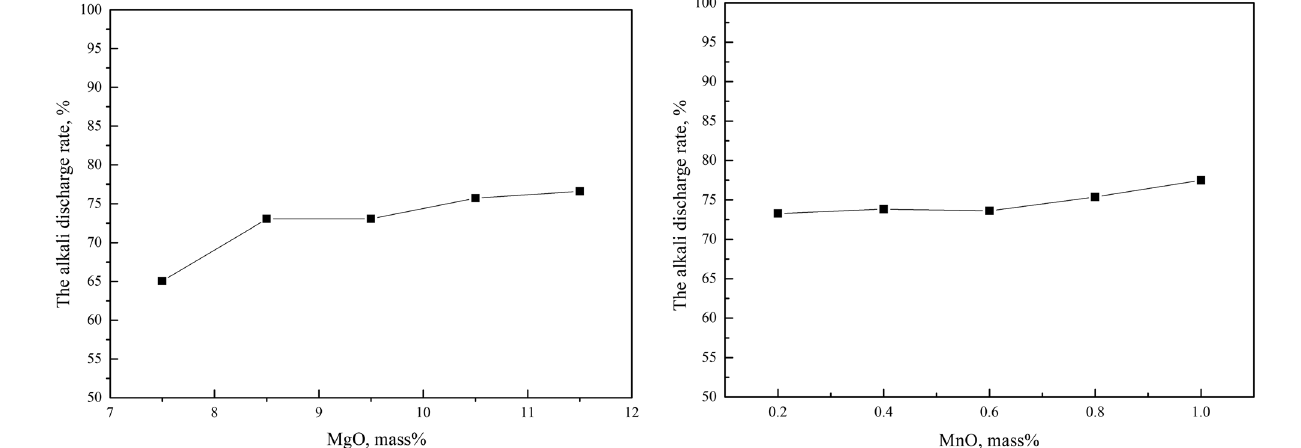
Figure 6: E ff ect of MgO on slag alkali metals discharge.